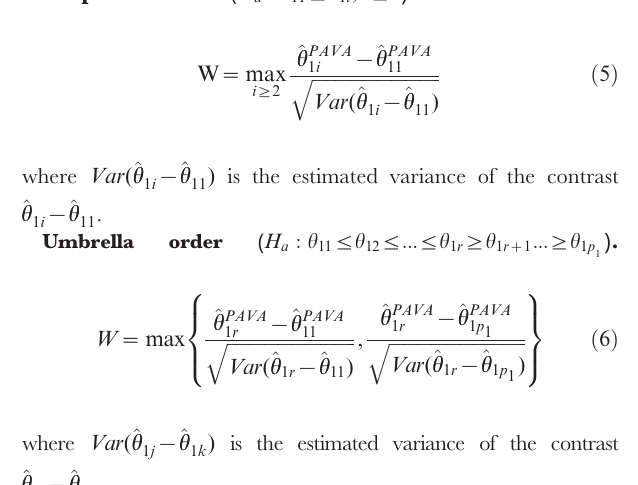
q ffiffiffiffiffiffiffiffiffiffiffiffiffiffiffiffiffiffiffiffiffiffiffiffiffiffiffiffi Var ( ^ hh